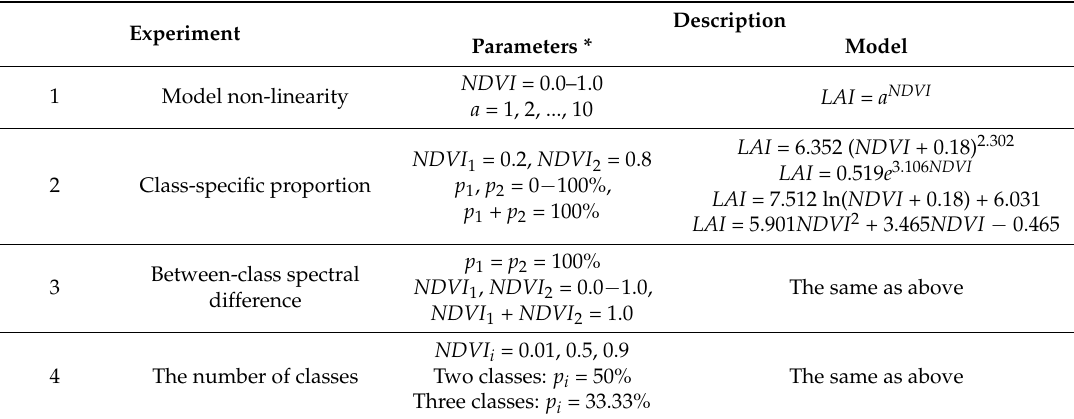
Table 2. Design of numerical simulation